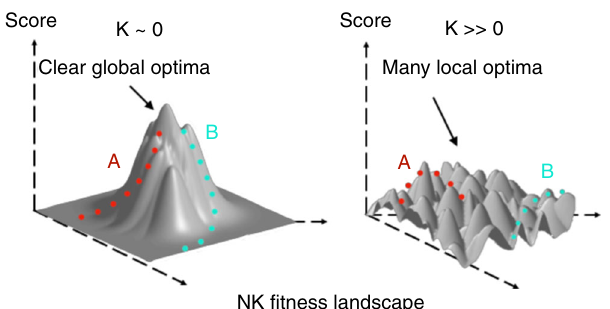
Fig. 1 NK space. Hypothetical plot of two NK problem spaces with